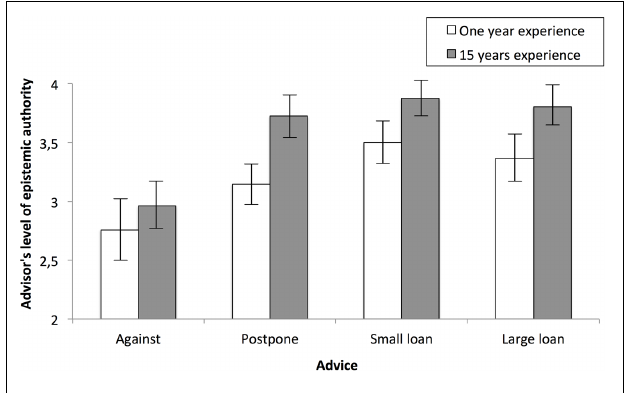
FIGURE 1 | Ascriptions of epistemic authority as a function of advisor’s experience and type of advice.